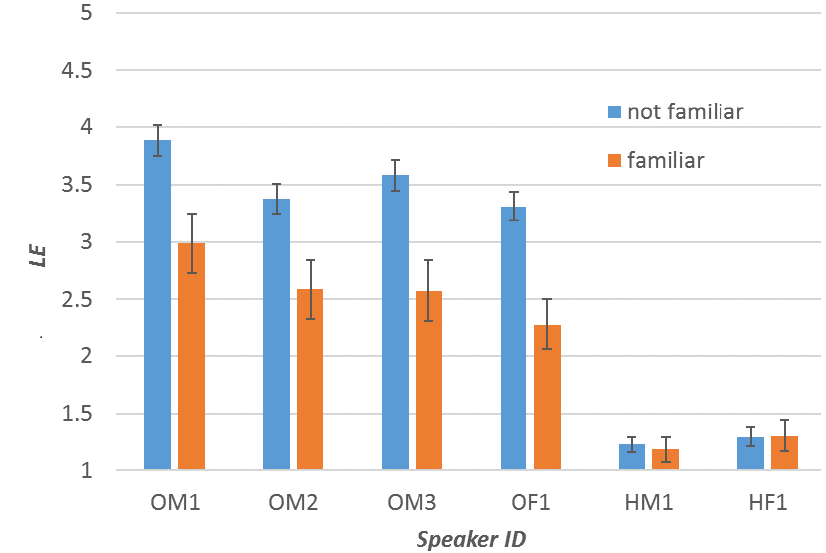
Figure 2. Mean speakerwise Listening Effort for oesophageal (OM1, OM2, OM3, OF1) and healthy (HM1, HF1) speakers. On the y-axis, 1 corresponds to least effortful and 5 to most effortful. Error bars show 95% confidence